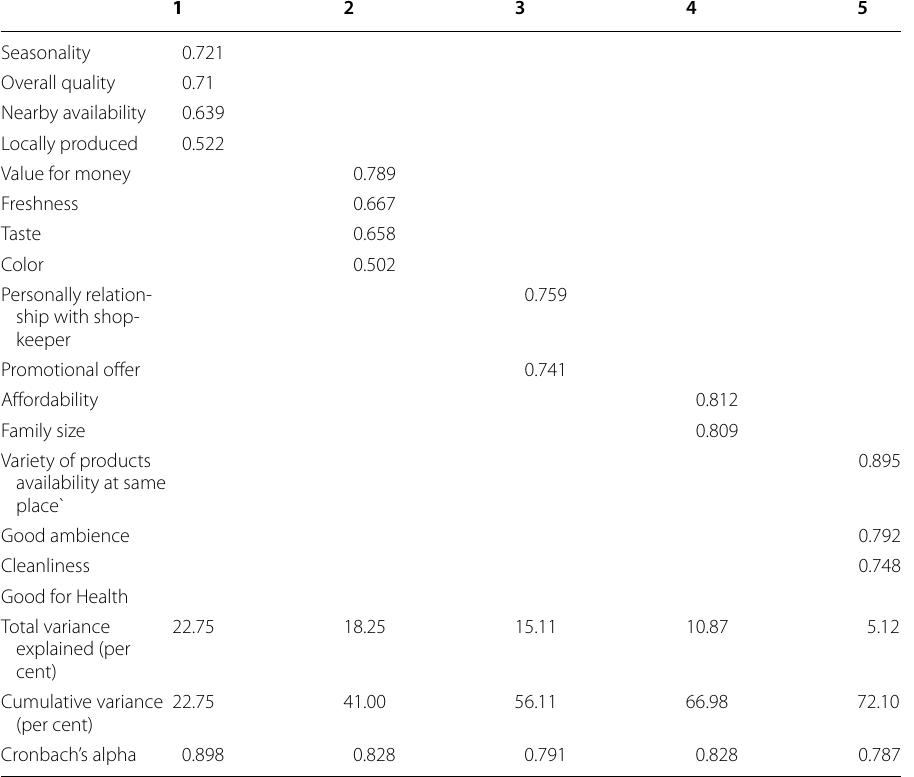
Extraction method: principal component analysis with varimax